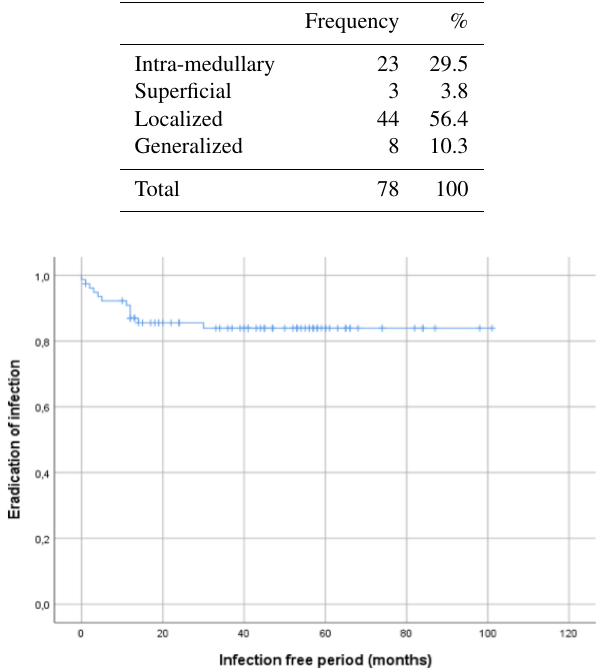
Figure 3. Kaplan–Meier survival curve displaying the infection- free period after initial treatment of all 78 included